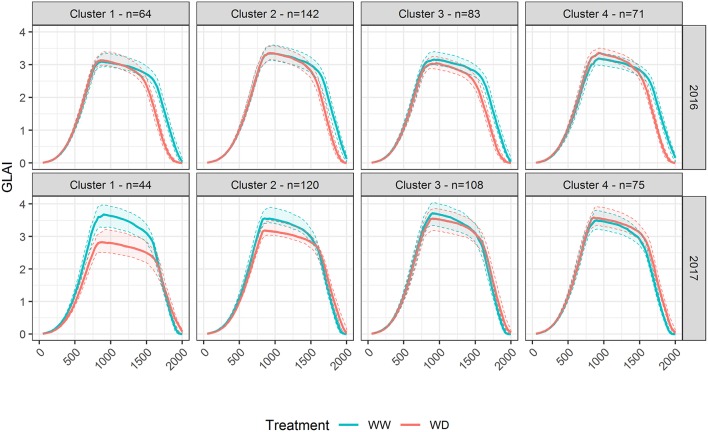
GLAI dynamics response to drought representative of the panel diversity in 2016 and 2017. The hierarchical clustering applied to the normalized difference of GLAI dynamics in Well-Watered and Water-Deficient treatments resulted in four distinct clusters in both years. The thick line represents the median of GLAIest for the genotypes in the corresponding cluster, while the thin dashed lines show the first and third quartiles. N is the number of genotypes in each cluster. Data are adjusted means.